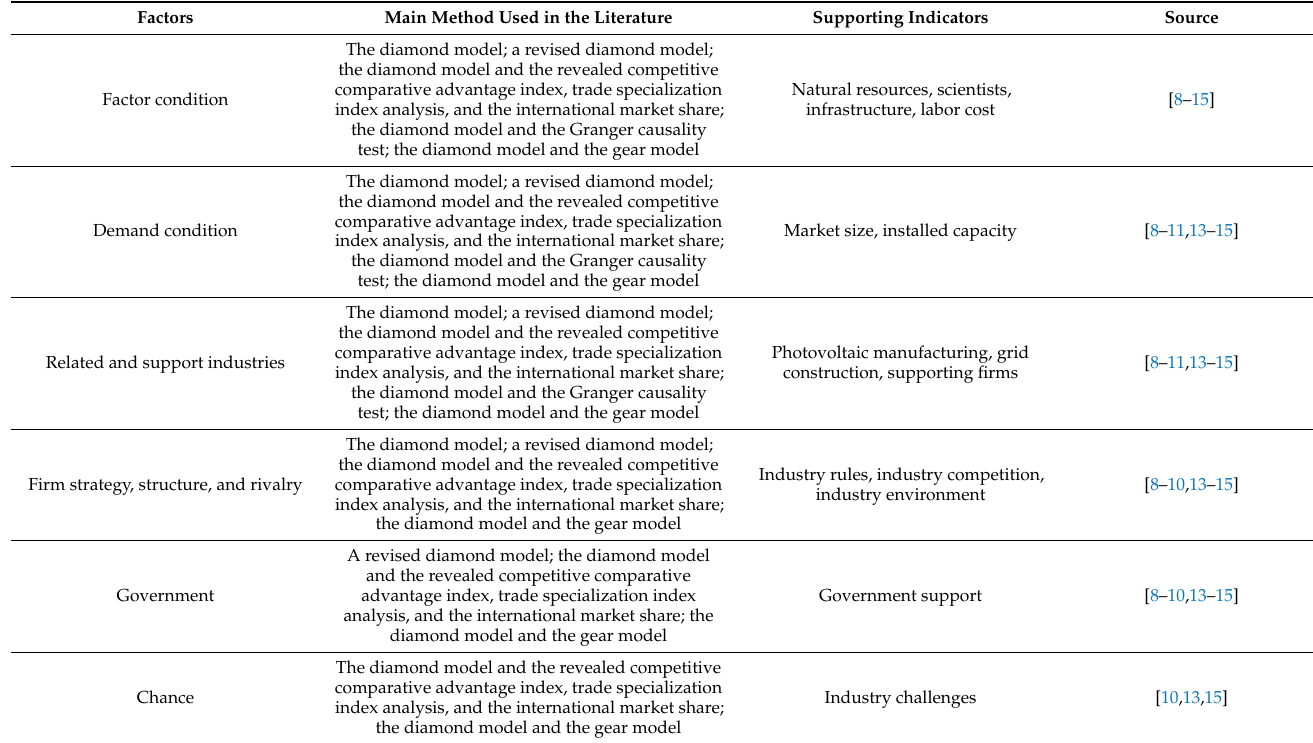
Table 1. Theoretical framework of the diamond model to evaluate the competitiveness of China’s photovoltaic industry. Factors Main Method Used in the Literature Supporting Indicators